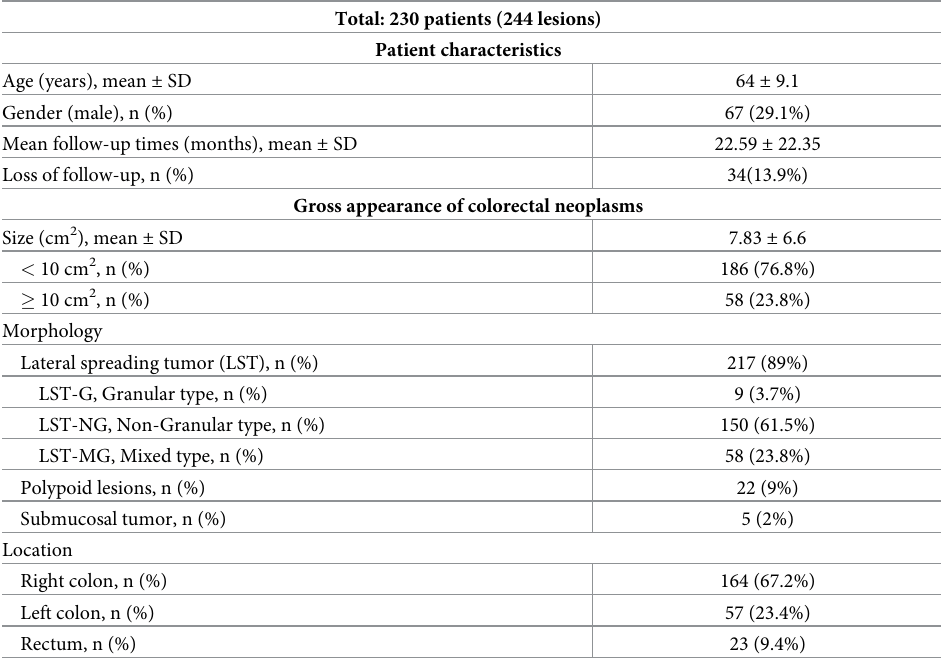
Table 1. Patient and gross appearance characteristics of colorectal